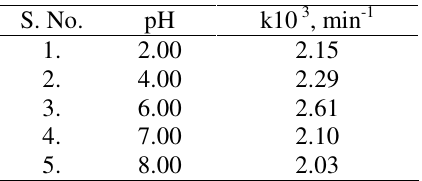
Table 3 . Effect of